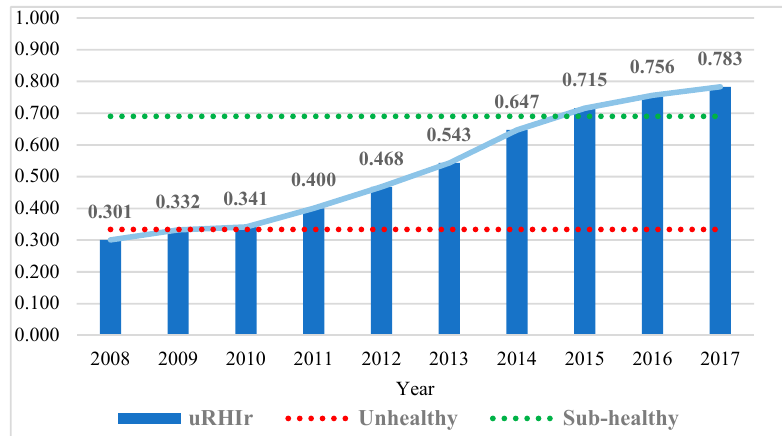
uRHI trend from 2008 to 2017. Figure 8. Jialu River uRHI R trend from 2008 to R